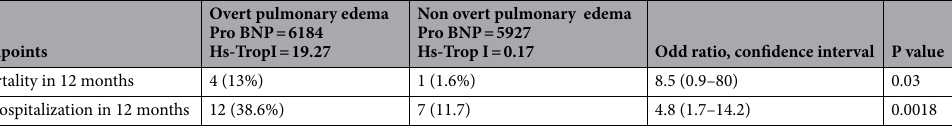
Table 3. Mortality and rehospitalization